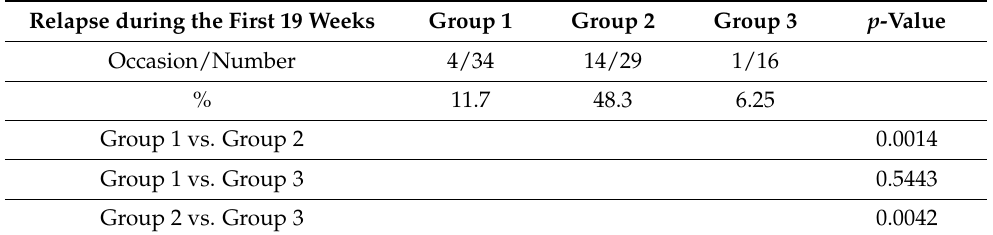
Table 9. A comparison of the three created groups in terms of early (during first cycle of treatment)